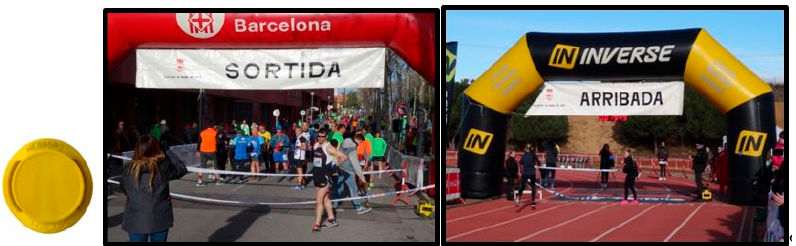
Figure 1. RFID Solution.